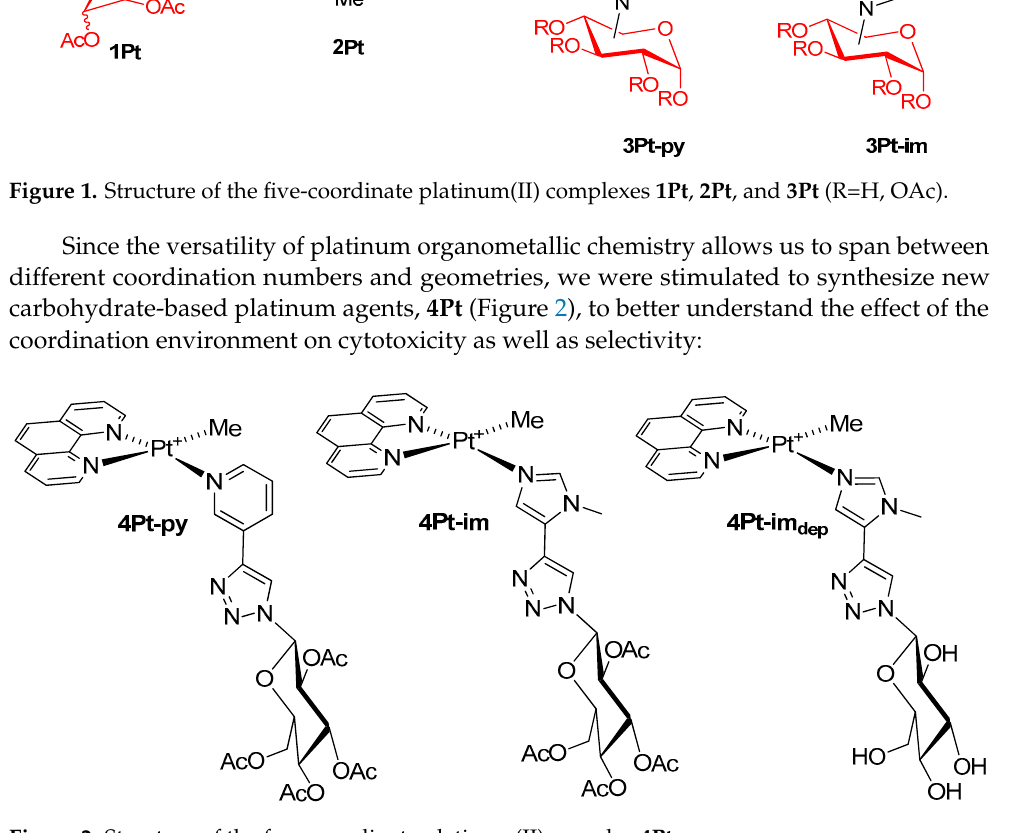
Figure 2. Structure of the four-coordinate platinum(II) complex 4Pt.